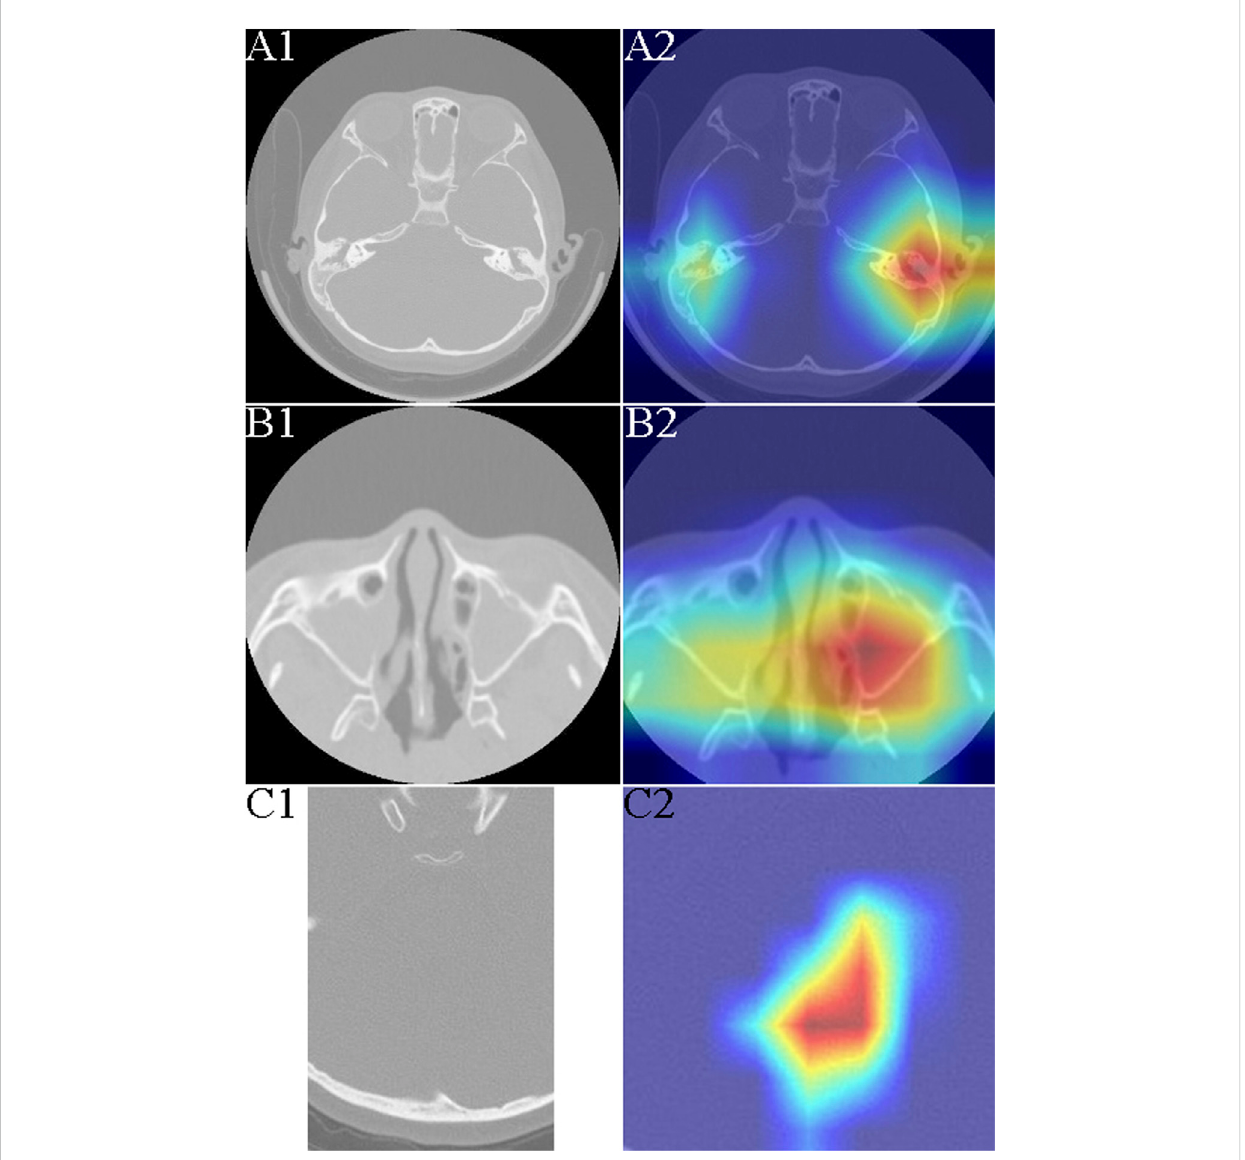
FIGURE 2 Typical heat mapping of themiddle ear mastoid,maxillary sinus, and fourth ventricle inpatients with primary ciliary dyskinesia(PCD) and thecontrol group. (A1) Computed tomography (CT) imageof middle ear mastoid in apatient with exudative otitismedia (OME). (A2) CT image ofmiddle ear mastoid in a patient with PCD and OME. (B1) CT image of maxillary sinus in a patient with sinusitis. (B2) CT image and heat mapping of maxillary sinus in a patient with PCD and sinusitis. (C1) CT image of fourth ventricle in a patient with PCD. (C2) CT image and heat mapping of fourth ventricle in a patient with